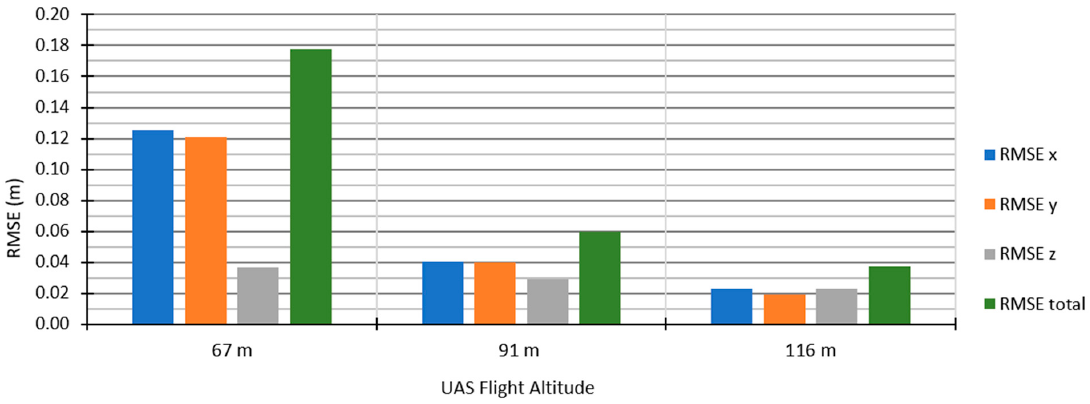
Figure 6. Check point RMSEs for various UAS flight altitudes.